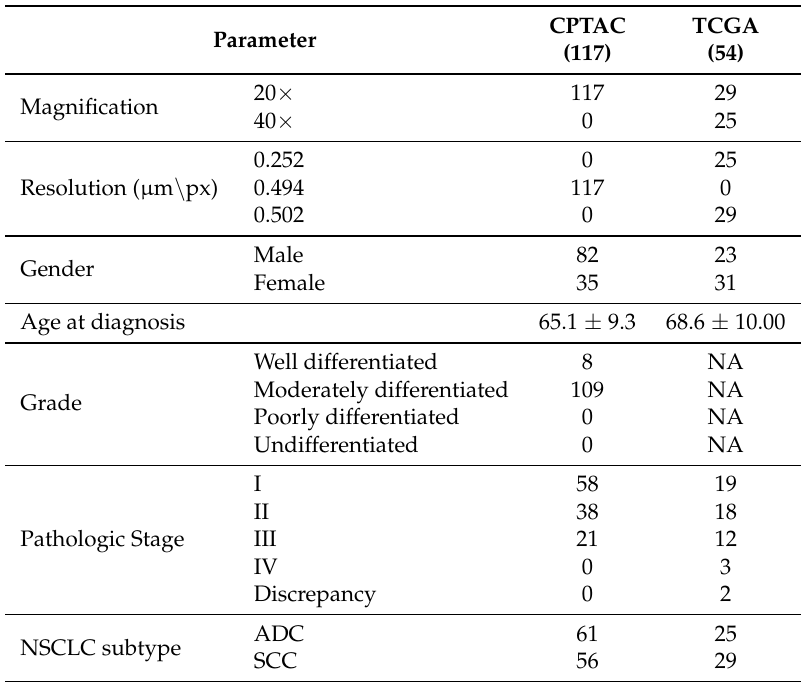
Table 1. Summary of imaging parameters, demographic, and pathologic information of the whole slide image (WSI) cohort used in this